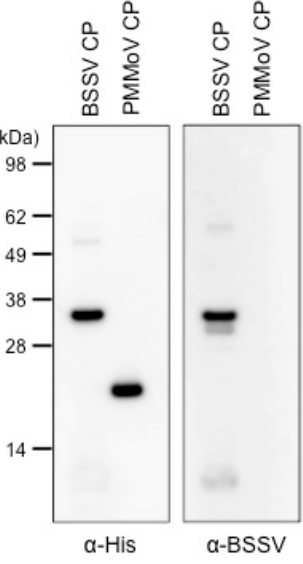
Figure 4. Detection of a recombinant putative coat protein of BSSV using an immunoblotting assay. The left panel shows recombinant proteins detected with an anti ‐ histidine antibody. The right panel shows recombinant proteins detected with an anti ‐ BSSV ‐ antibody.